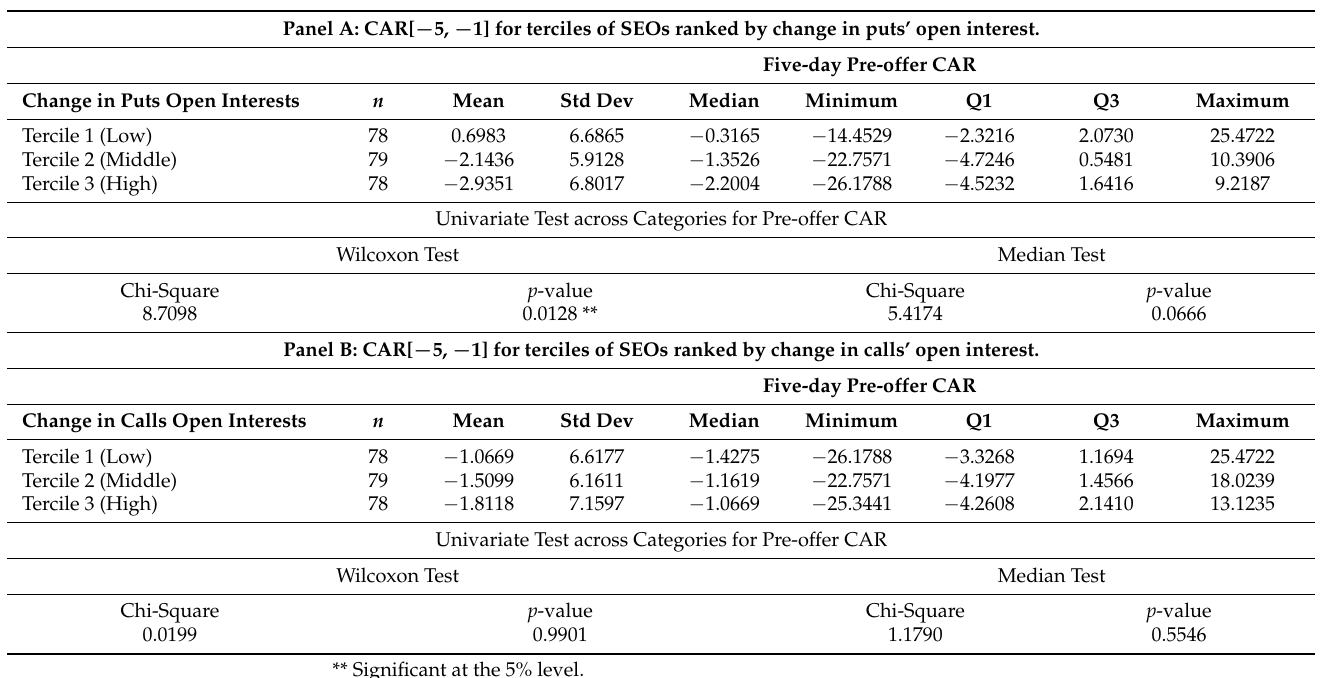
Table 6. Five-day Pre-offer CAR by